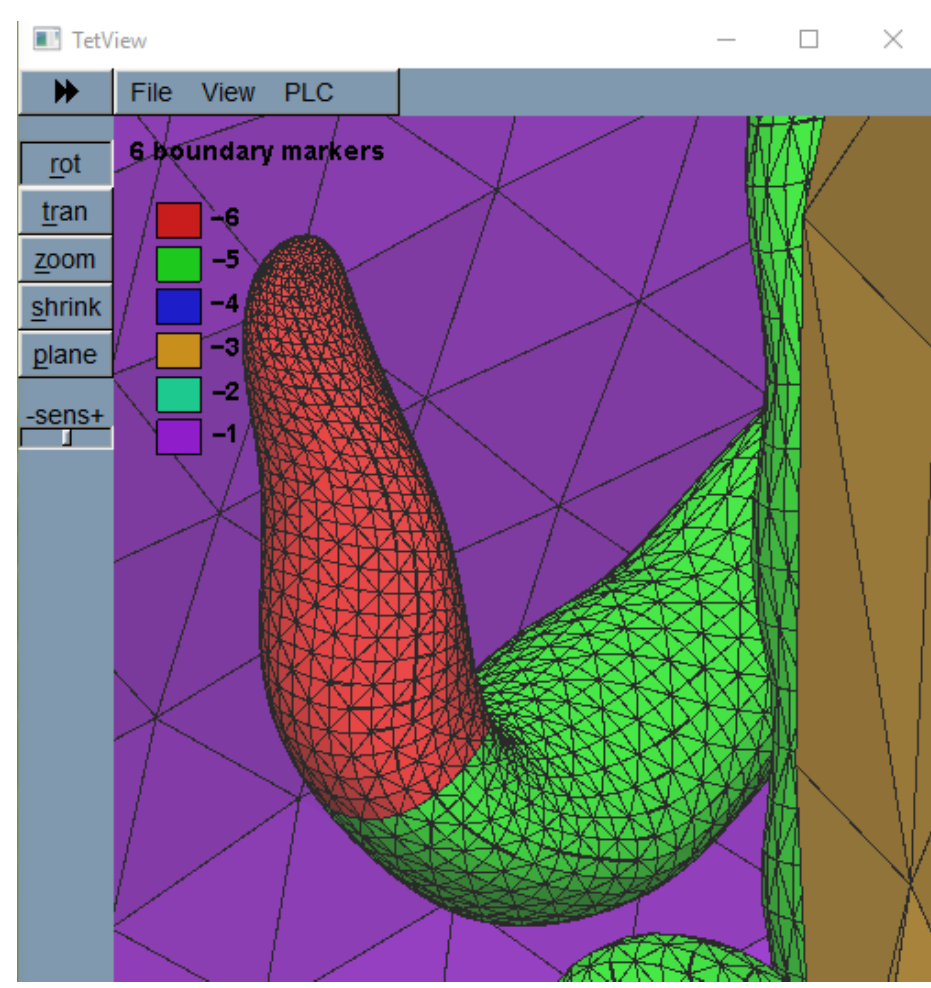
Figure 5. Microtubule with fitted surface mesh. The microtubule terminal − red ( − 6), the body of the microtubule − green ( − 5), mitochondrion − gold ( − 3), membrane − purple ( − 1). The input mesh was made up of 41,807 vertices and 83610 triangles—Figure